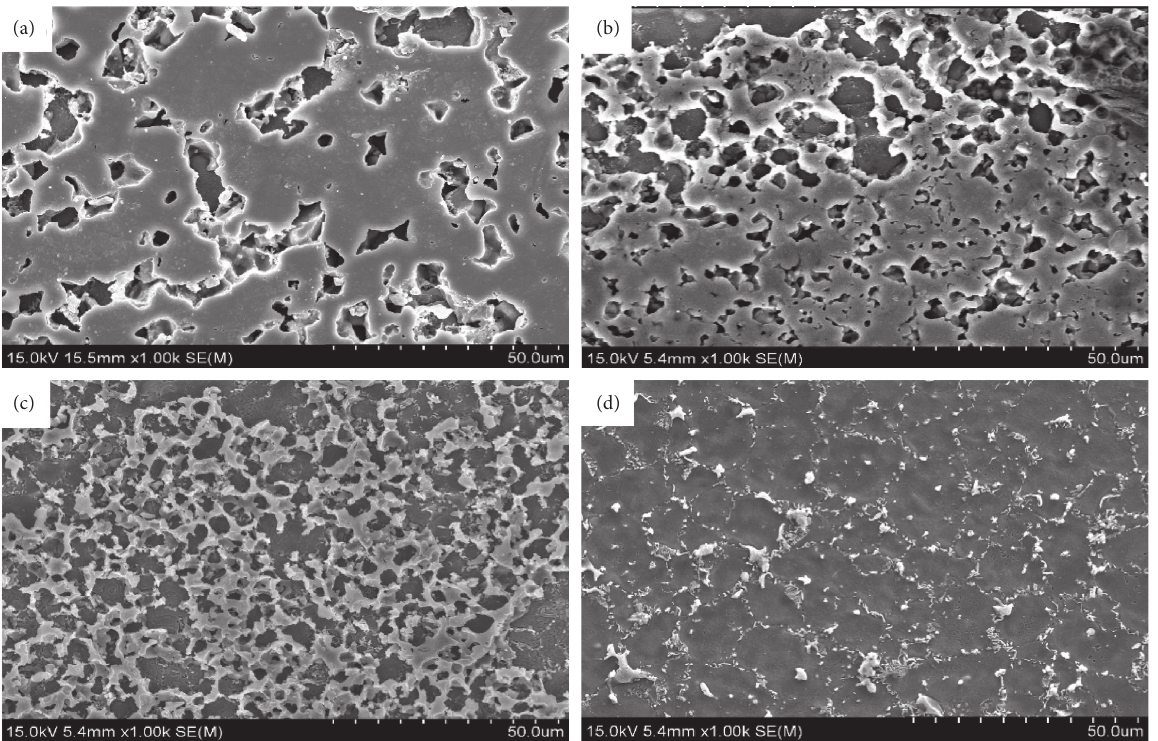
Figure 15: SEM view and element analysis of the ES.